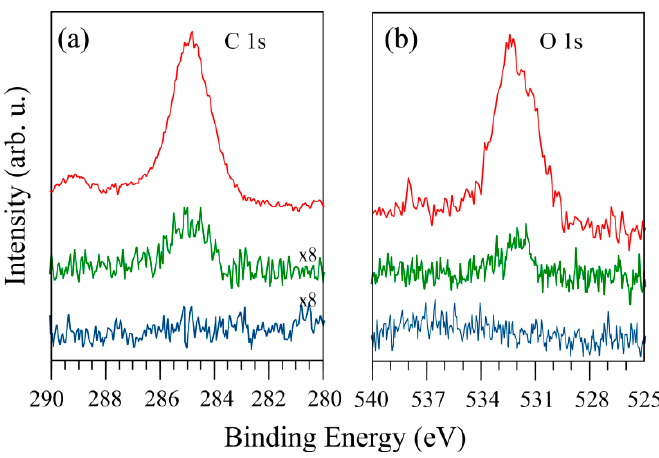
Figure 4. XPS spectrum intensity of ( a ) C-1s and ( b ) O-1s for a nondoped GaN(0001) surface. Upper spectrum corresponds to the degassed surfaces in UHV; lower ones show the influence of different numbers of annealing cycles at 800 °C.